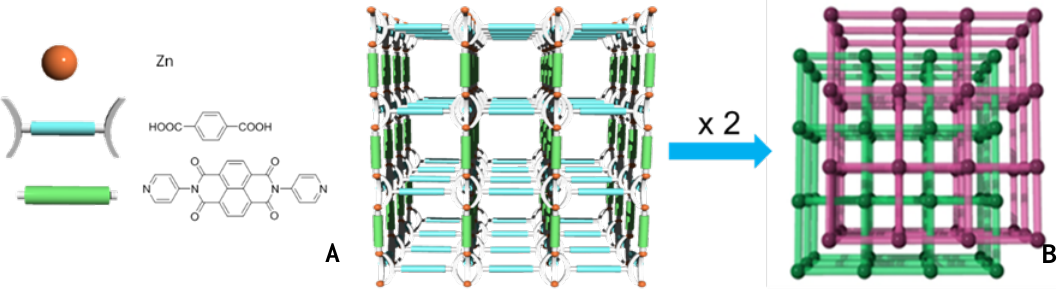
A B Figure 1. ( A ) Illustrative representation of one of the two identical frameworks that compose the [Zn 2 (bdc) 2 (dpNDI)] n MOF indicating its different components; ( B ) an schematic representation of the interpenetration of the two identical frameworks.